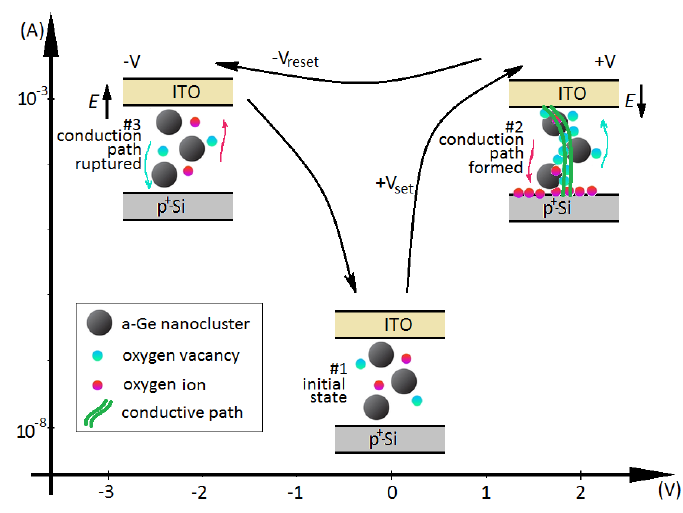
Figure 9. Schematics of the formation ( right ) and rupture ( left ) of a conducting a-Ge-based filament in the GeSi x O y structure under the external electric field, taking into account the movement of oxygen ions and oxygen vacancies.